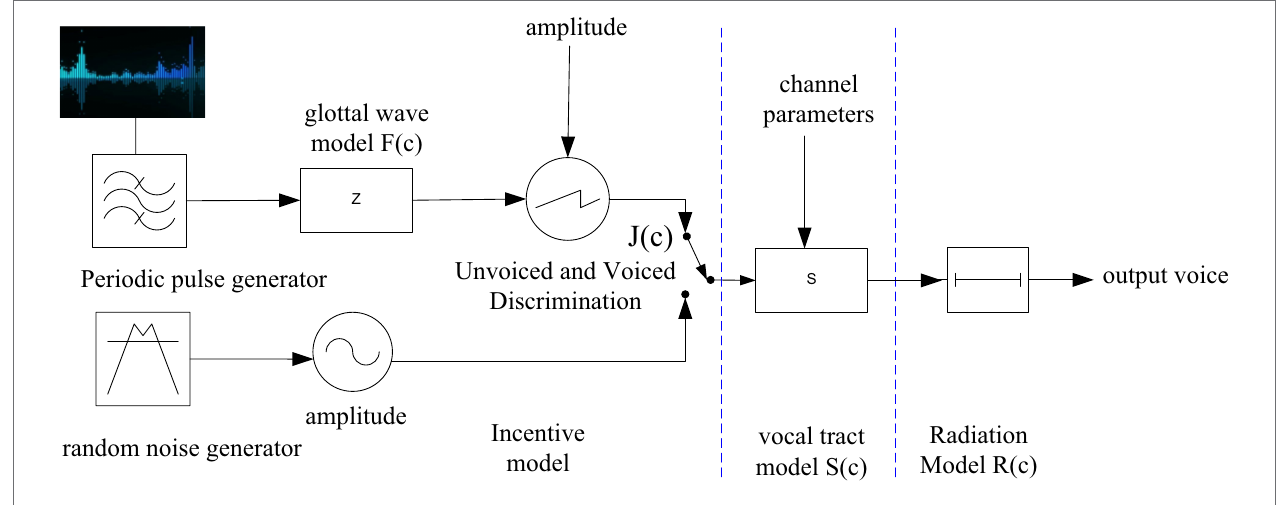
FIGURE 2 | Digital model of speech signal